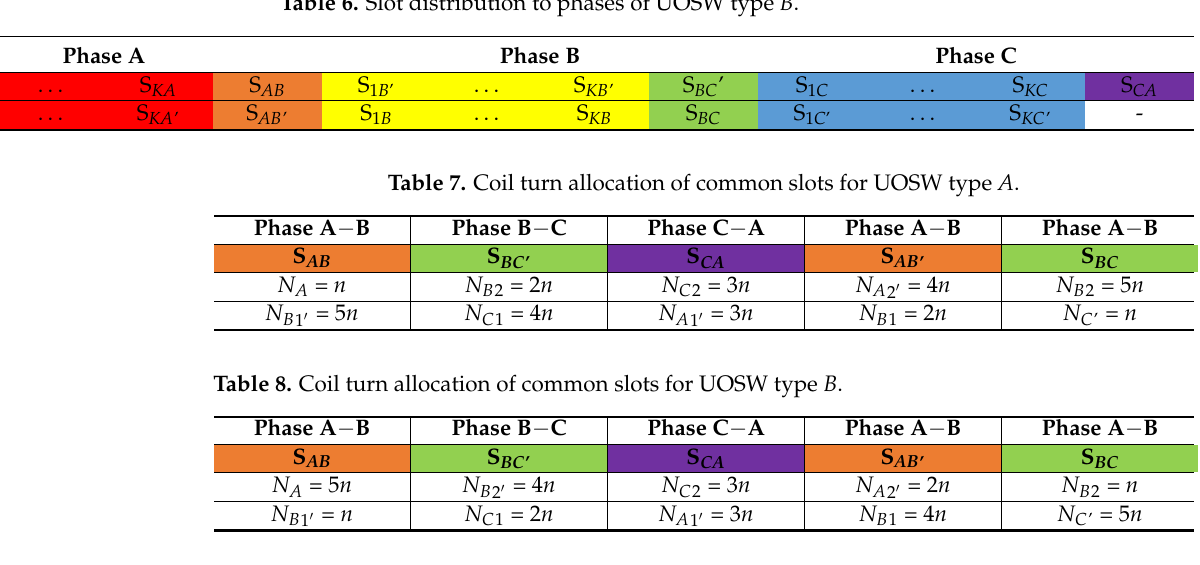
Table 6. Slot distribution to phases of UOSW type B .